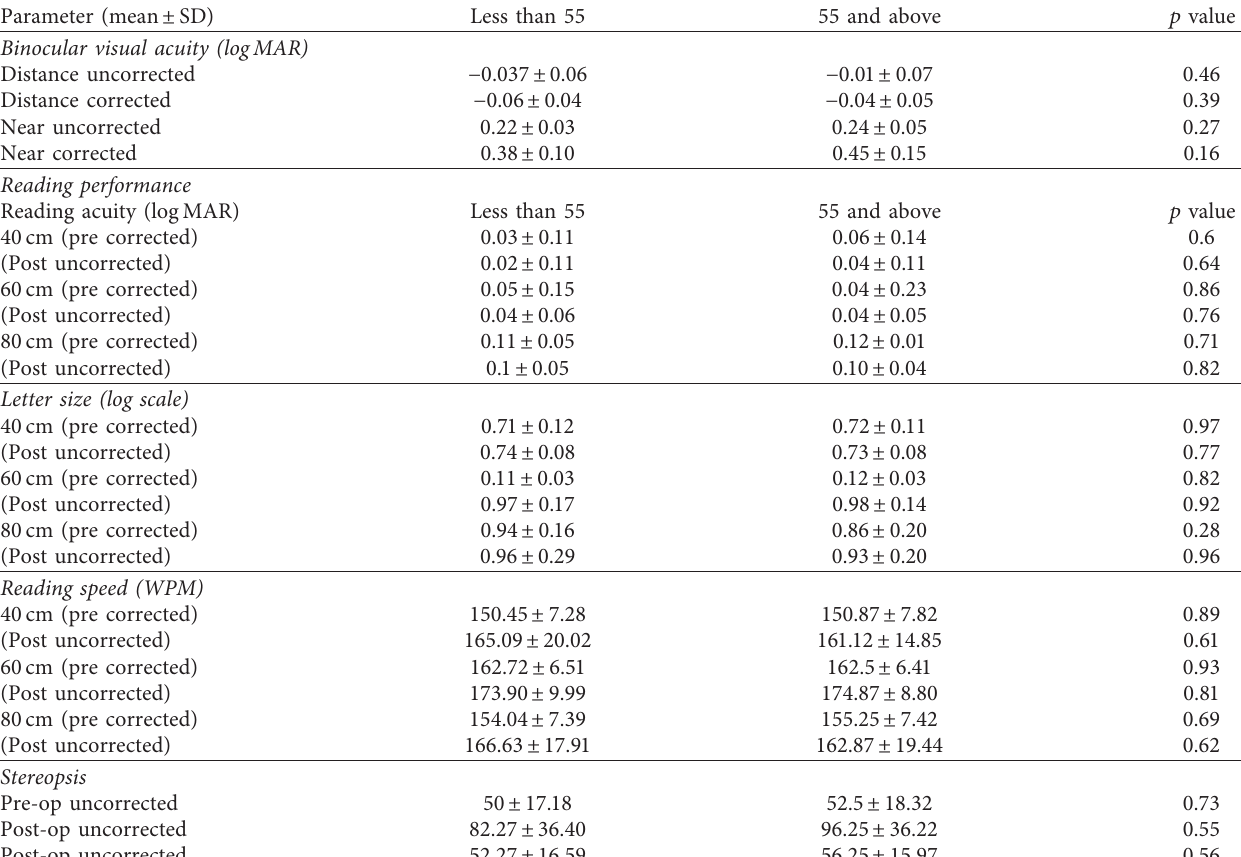
Figure 5: Binocular reading performance evaluated using SRD at preferred reading distance, 60cm, and 80cm. (a) Reading speed. (b) Letter size. Table 3: Subgroup analysis for patients aged “less than 55 years” and “55 years and